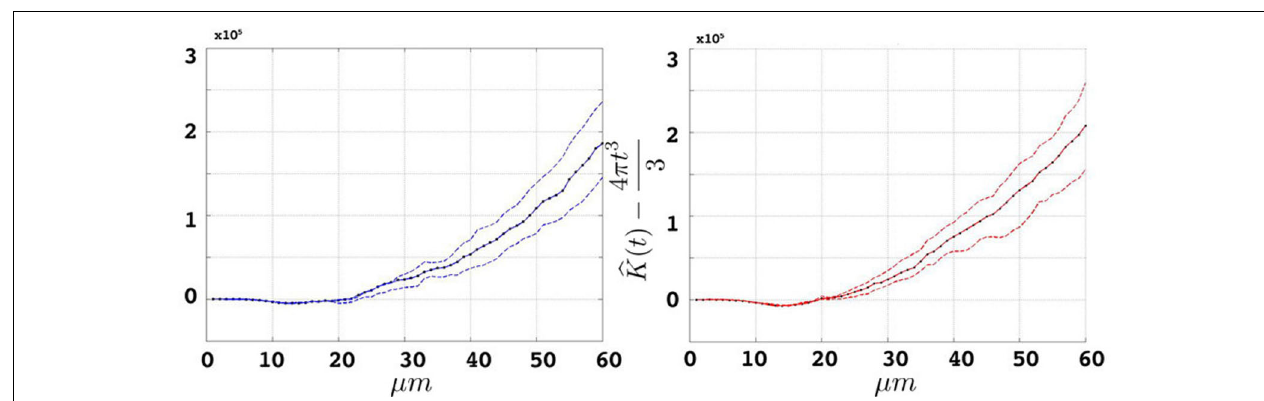
FIGURE 8 | Groupwise average (weighted) K t t (cid:3) ( ) 4 /3 3 − π for etv- (left) and glt-pyramids (right) and confi dence intervals based on the bootstrap procedure